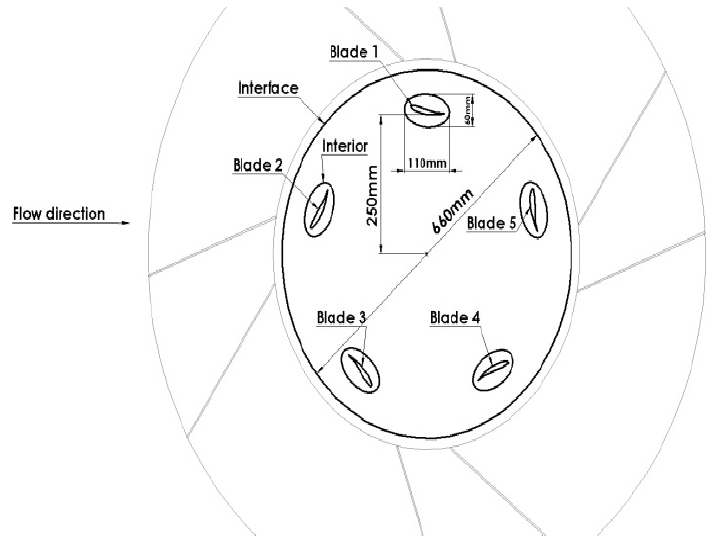
Figure 5. Boundary around the VAWT.